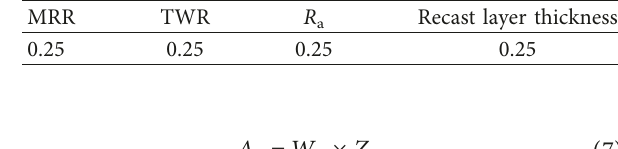
Table 15: Weights of the response